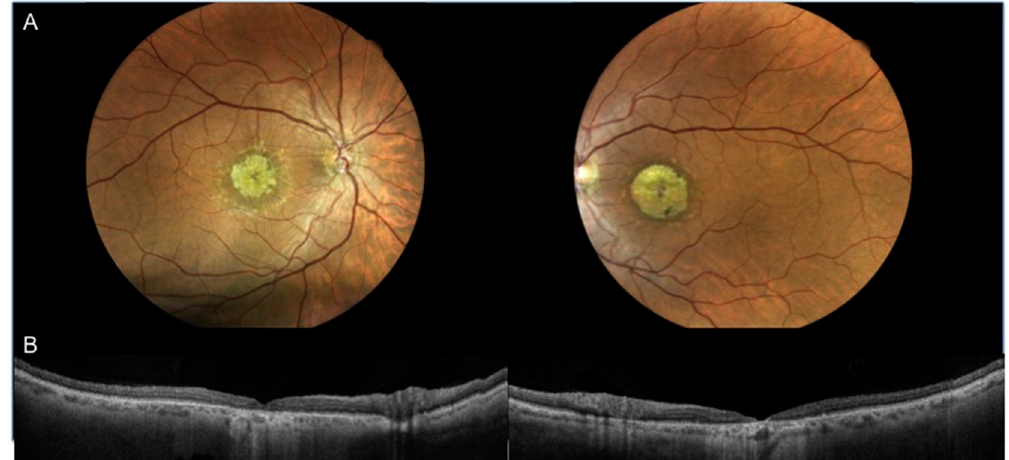
Figure 3. Case 2: Color fundus photographs ( A right and left) showing macular atrophy with surrounding flecks and swept source optical coherence tomography angiography 12-mm scan ( B right and left) passing through the fovea showing loss of inner and outer retinal layers ELM defect, inner segment ellipsoid band defect, thinner RPE / Bruchs complex, hyperreflective material located at the RPE level.